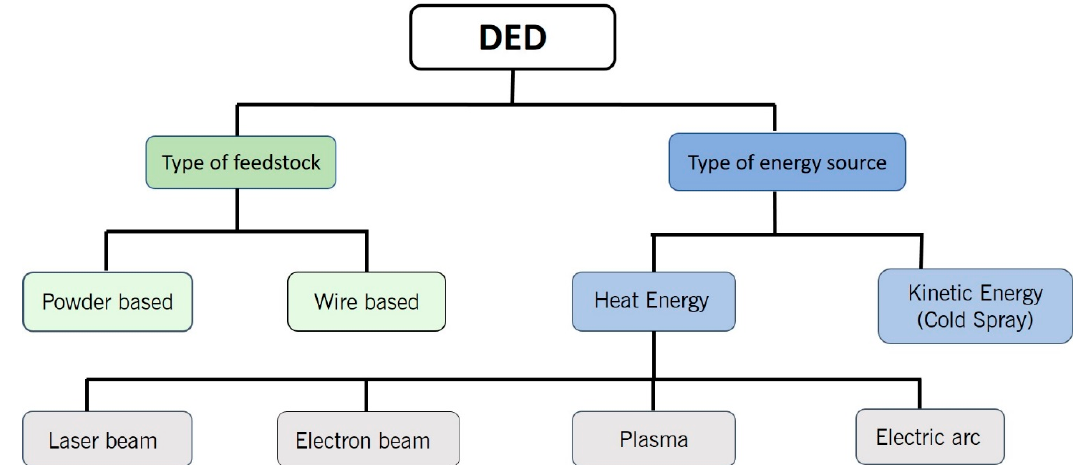
Figure 1. Classification of Directed Energy Deposition (DED) systems.